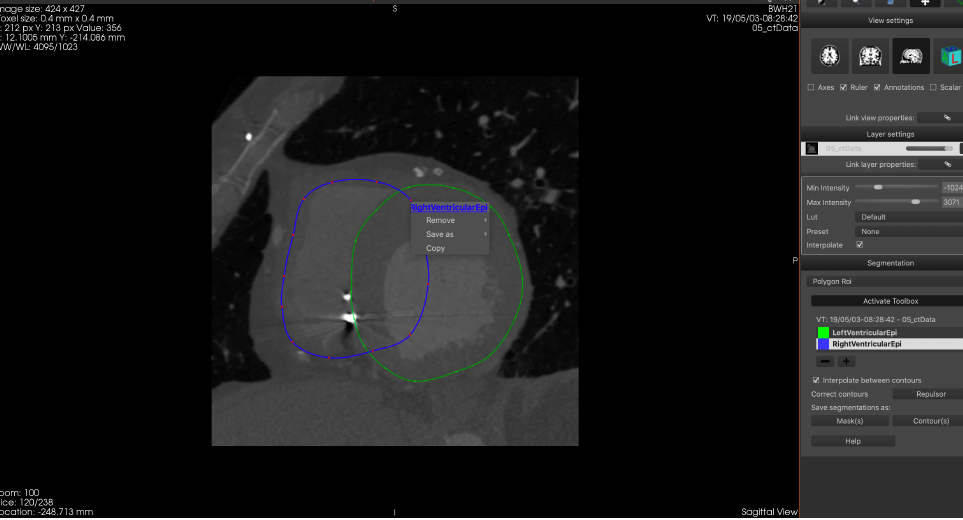
Figure 5. Contours segmented in polygon ROI toolbox. This example shows an ongoing segmentation of the left (green) and right (blue) ventricles of the